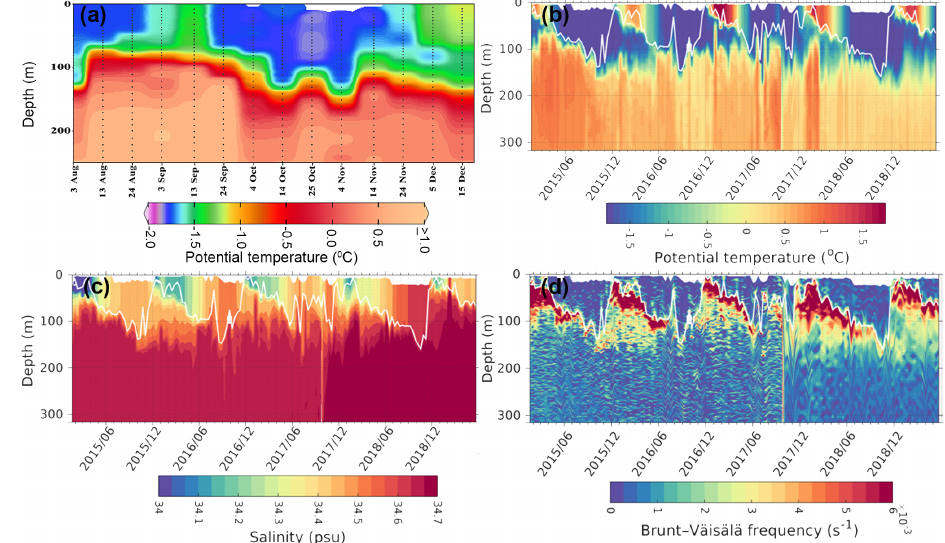
Figure 6. Profiles from an Argo float ID 5904468 located at the edge of the Maud Rise polynya show (a) potential temperature during August–December 2017, (b) potential temperature during 2015–2019, (c) salinity, and (d) static stability. The white solid line shows the variability of mixed-layer depth. The mixed layer was computed as the uppermost level of uniform potential density ( σθ) at the depth where the density in the upper level varies by 0.01kgm − 3 with respect to the surface (Kaufman et al.,